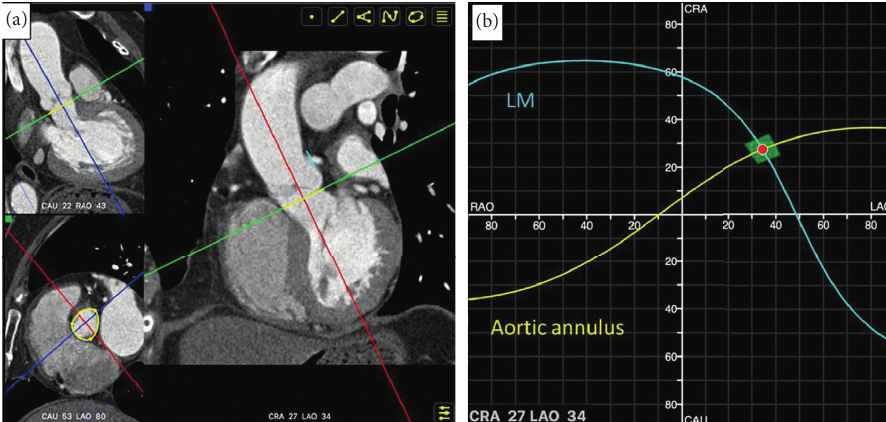
Figure 2: Optimal projection to visualize the LMCA ostium estimated by FluoroCT: (a) the aortic annulus (yellow line) and LMCA plane (blue line) were determined; and (b) the optimal projection of the LMCA ostium was fixed when two S-curves consisting of an unlimited number of pairs of C-arm angulations which were tangential to the aortic annulus and the LMCA ostium crossed. LAO � left anterior oblique; RAO � right anterior oblique; CRA � cranial; CAU � caudal.